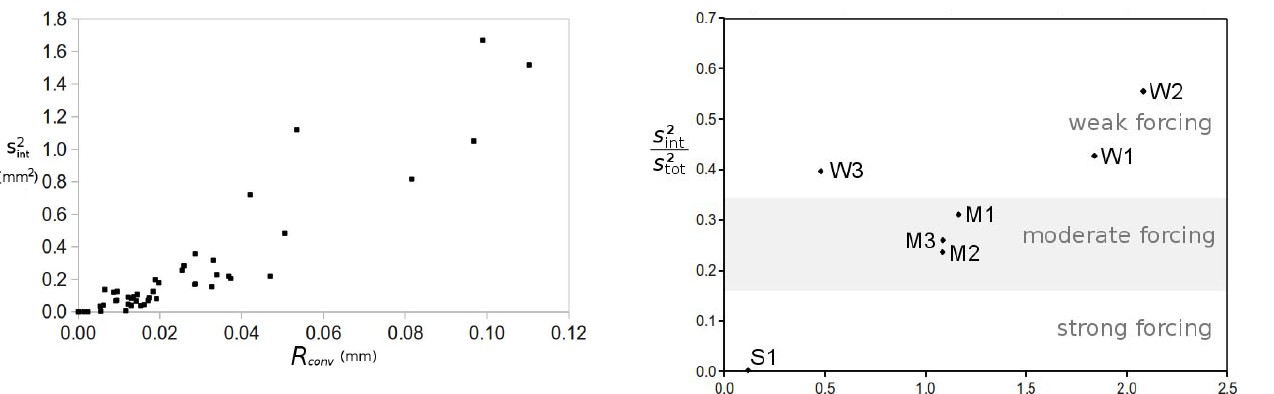
(closed triangles) int